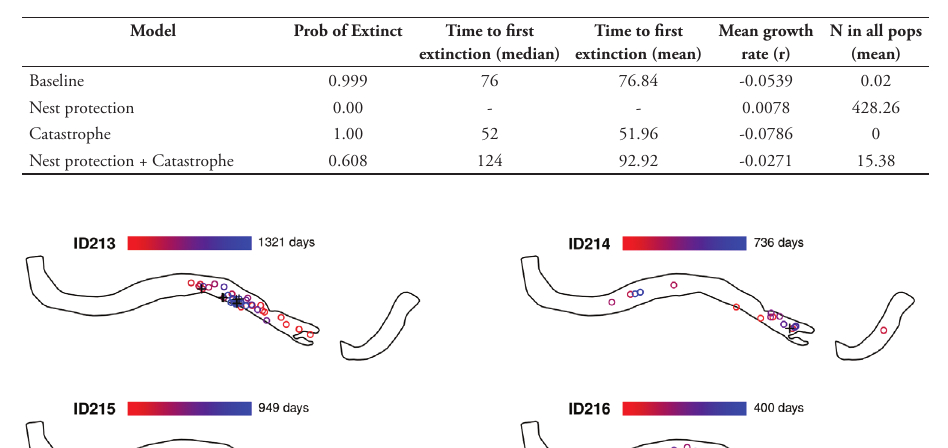
Table 2. Summary of the results of the simulated population viability models.